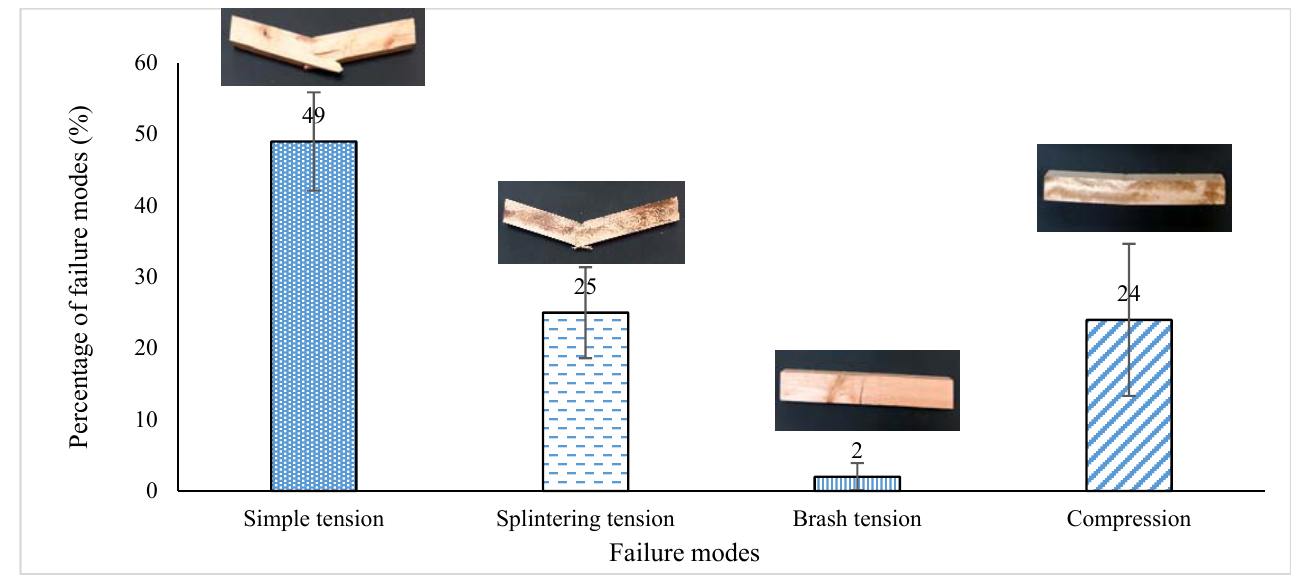
Figure 4. Types and percentage of occurrence of failure (in static bending) of Eucalyptus urograndis.